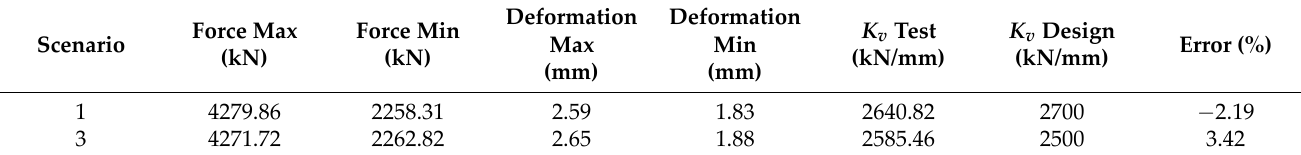
Figure 6. The force ‐ deformation curve of ( a ) NRB ‐ 600 and ( b ) LRB ‐ 600 specimen under vertical loads